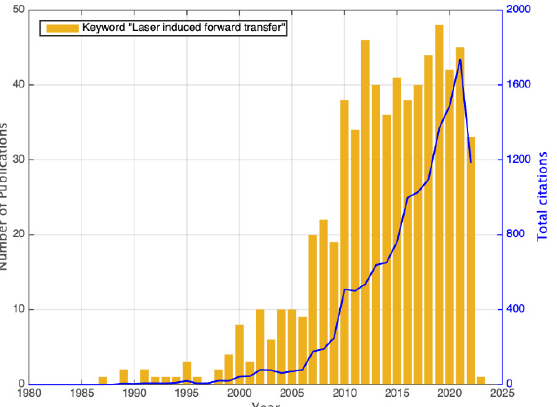
Figure 5. Number of published peer-reviewed articles (grand total of 661) and total number of citations per year. Data obtained via the ISI Web of Science, by sorting the keyword “laser induced forward transfer” as of 11 November 2022.